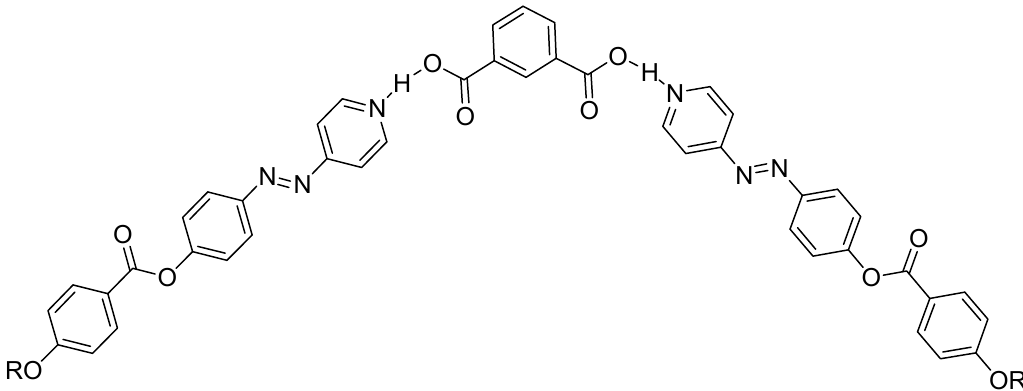
Figure 3. Di ff erential scanning calorimetry (DSC) thermograms upon the second heating / cooling cycles Figure 3. Differential scanning calorimetry (DSC) thermograms upon the second heating/cooling of the 2:1 SMHB complexes with a rate 10 ◦ C / min: ( a ) I6 / A and ( b ) I6 / cycles of the 2:1 SMHB complexes with a rate 10 ° C/min: ( a ) I6/A and ( b ) I6/B.